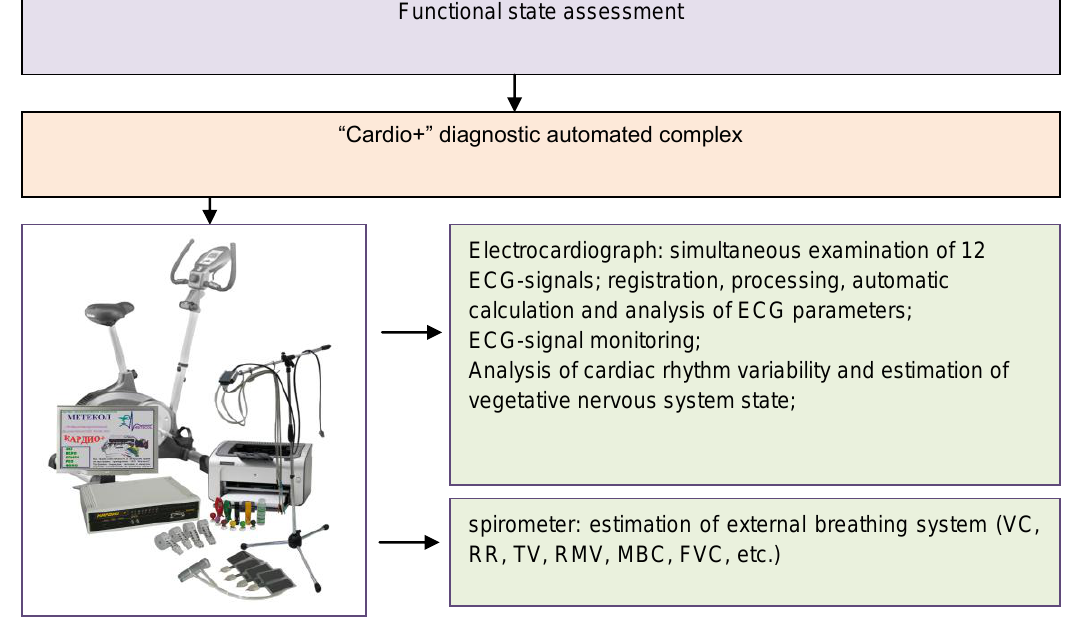
Fig. 6. Estimation methods of functional state of skilled track and field athletes – members of reserve national team of